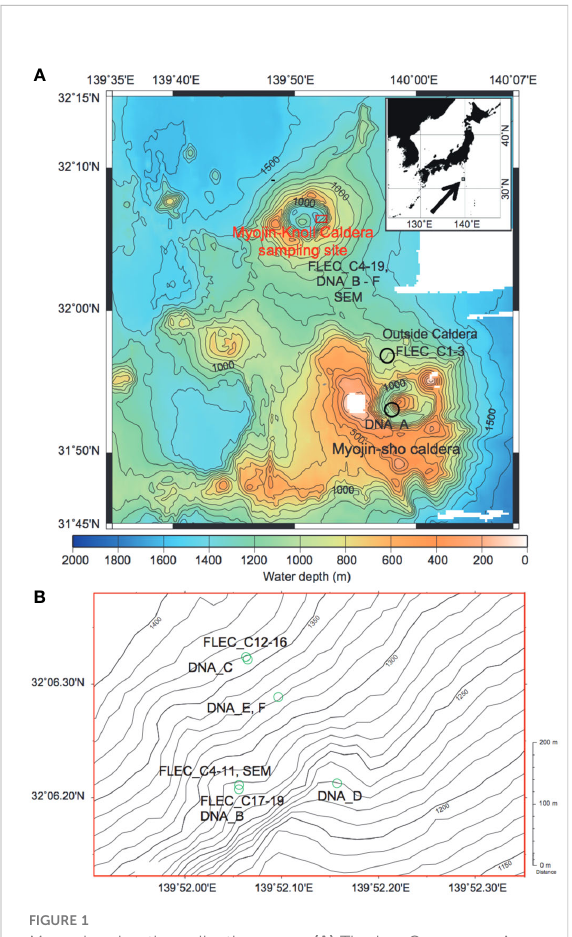
FIGURE 1 Maps showing the collection areas. (A) The Izu-Ogasawara Arc region, showing location of Myojin Knoll and Myojin-Sho Calderas in addition to sample sites outside Myojin Knoll Caldera. Inset: Index map showing location of A with respect to Japan. Contours in 100-m increments (modi fi ed from Nomaki et al., 2019). (B) Enlargement of area inside Myojin-Knoll showing locations of chimney-associated and non-chimney caldera samples. Contours in 10-m